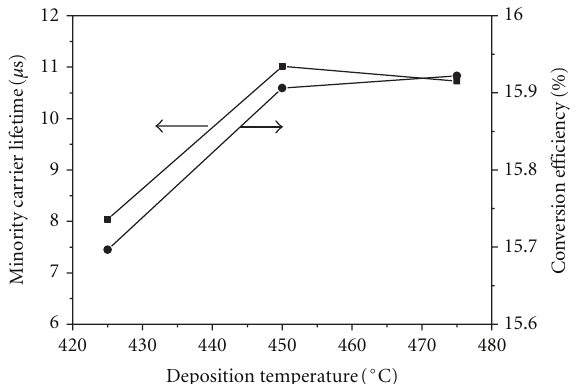
Figure 7: The minority carrier lifetime and conversion e ffi ciency versus deposition temperature.